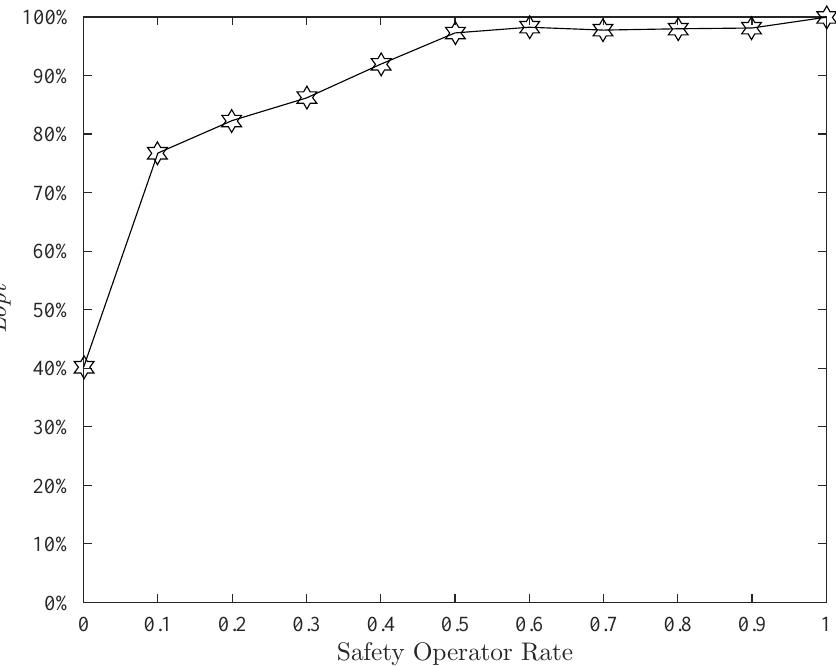
Figure 15. Effect of the safety operator